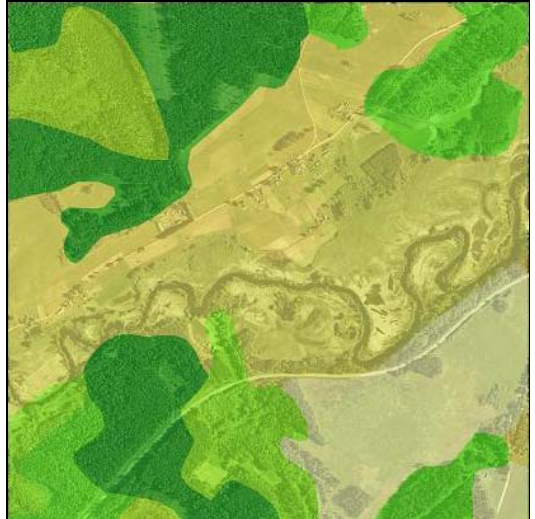
Fig. 4. Patchiness of coastal plain, sample No 89 (11 patches and 9 types of land cover, located near Palanga). This sample represents a geosystem with low buffer potential *